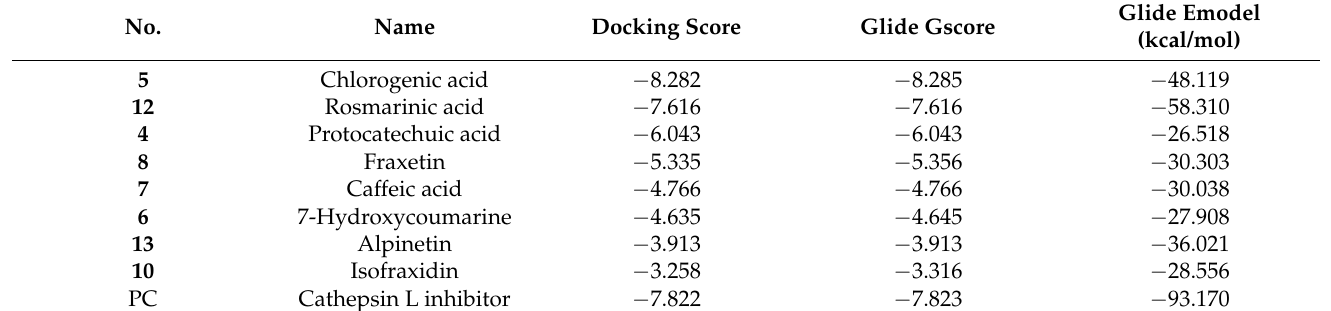
Table 5. Docking main bioactive compounds from Sarcandra glabra extracts against CatL PR. (PDB ID: 3OF9).